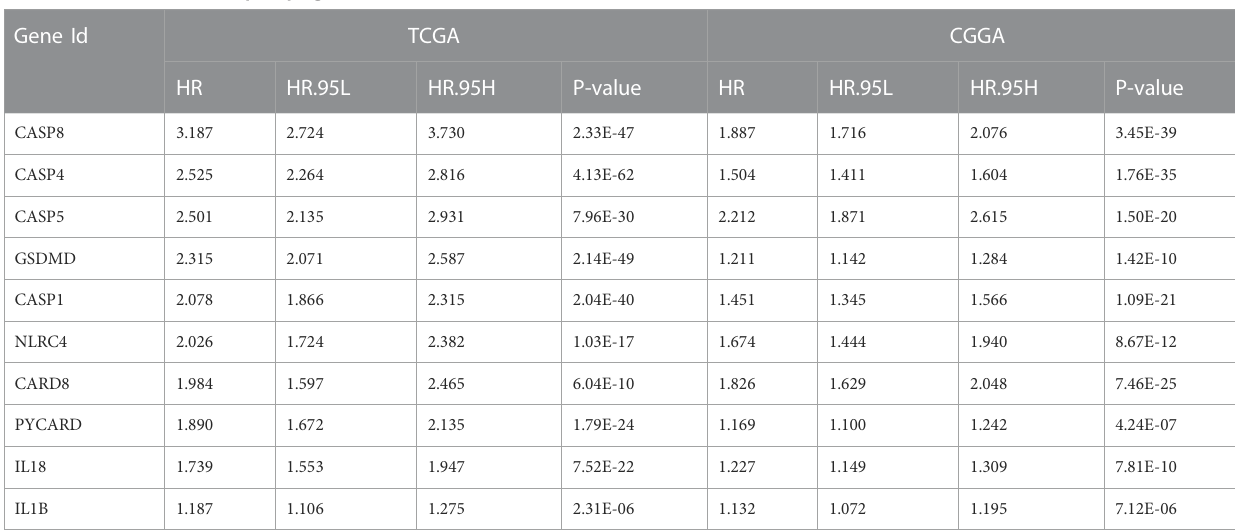
TABLE 2 The information of top 10 prognostic